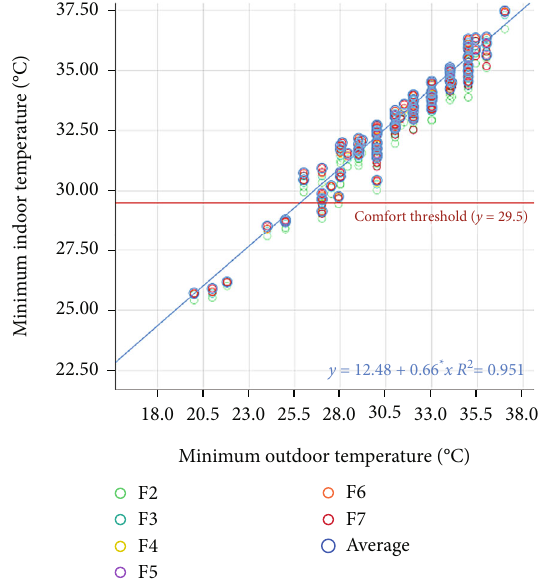
Figure 10: Daily maximum indoor temperatures in relation to maximum outdoor temperatures.